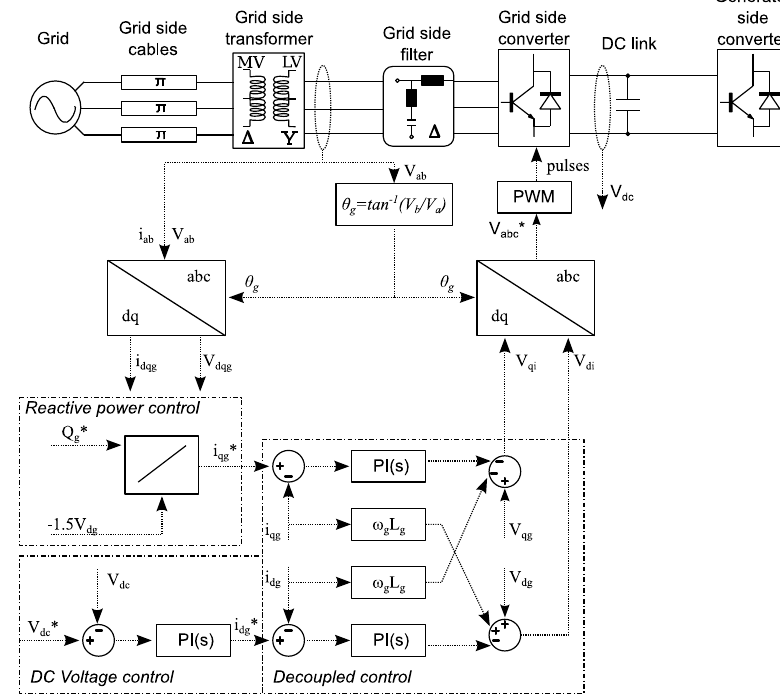
Figure 6. Block diagram of the Voltage Oriented Controller as it was implemented in MATLAB / Simulink. The point of measurement for the electrical quantities is at the low voltage side of the power transmission transformer after the grid-side filter. Table 3. Parameters for the BTB power converters and